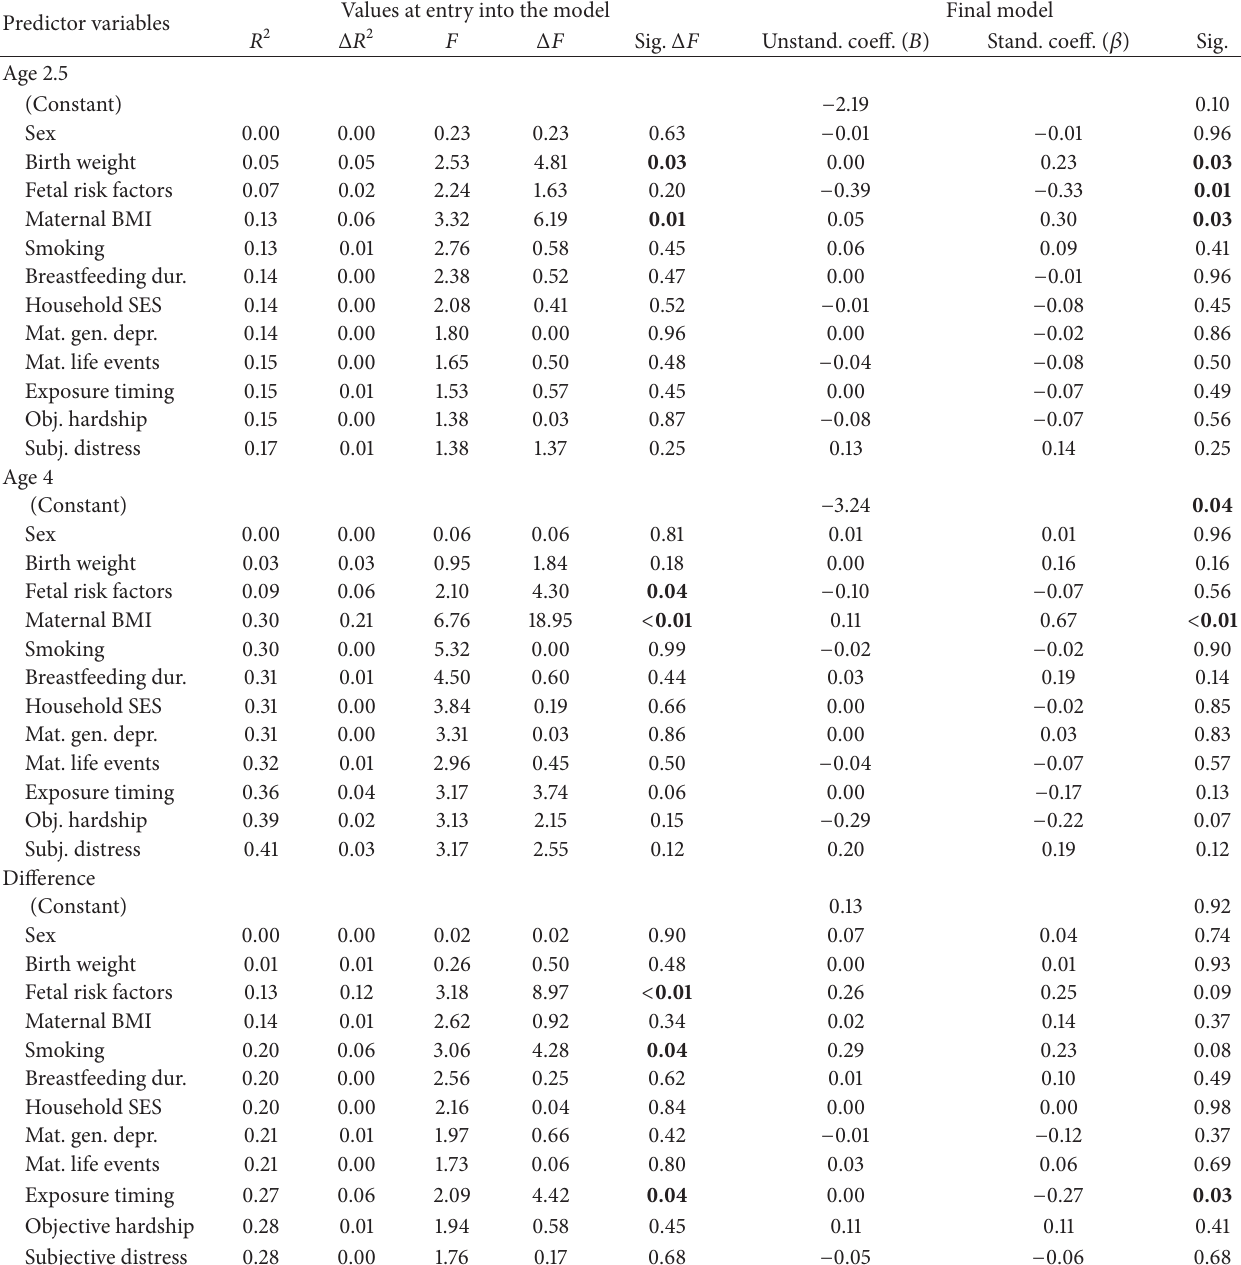
Table 2: Summary of hierarchical linear regression analyses for body mass index (BMI). Significant effects are indicated in bold. Predictor